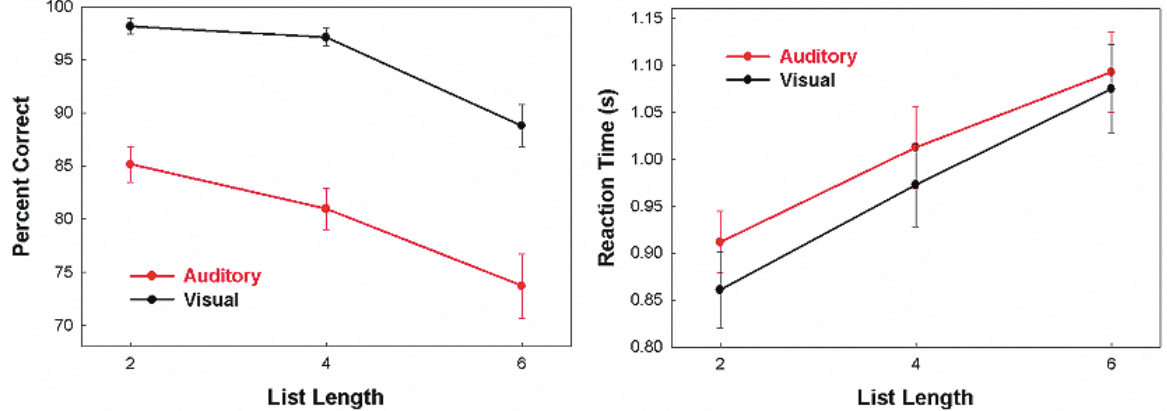
Fig. 2. Reaction time and accuracy plots. Plot of reaction time (left) vs. memory load (list length) and accuracy (right) vs. memory load.